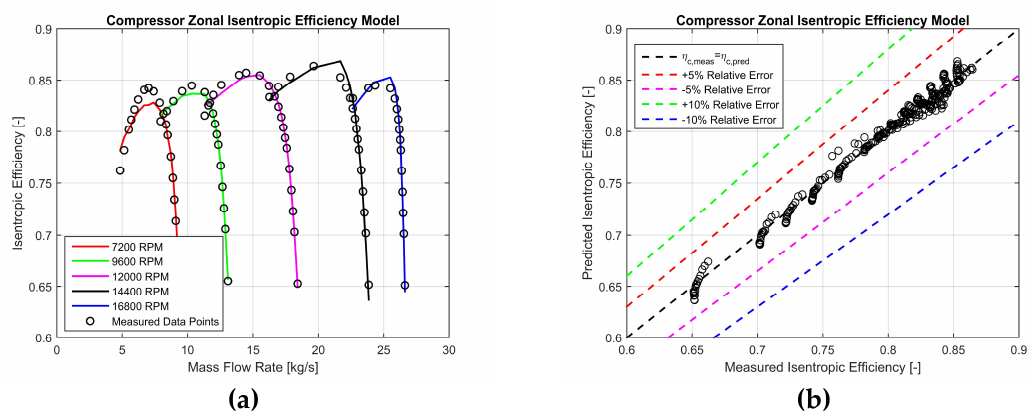
Figure 8. Prediction result and error distribution for compressor zonal isentropic efficiency model: ( a ) predictive result; ( b ) error distribution. Table 2. Error evaluation criteria result for Hadef model and zonal compressor isentropic efficiency model.